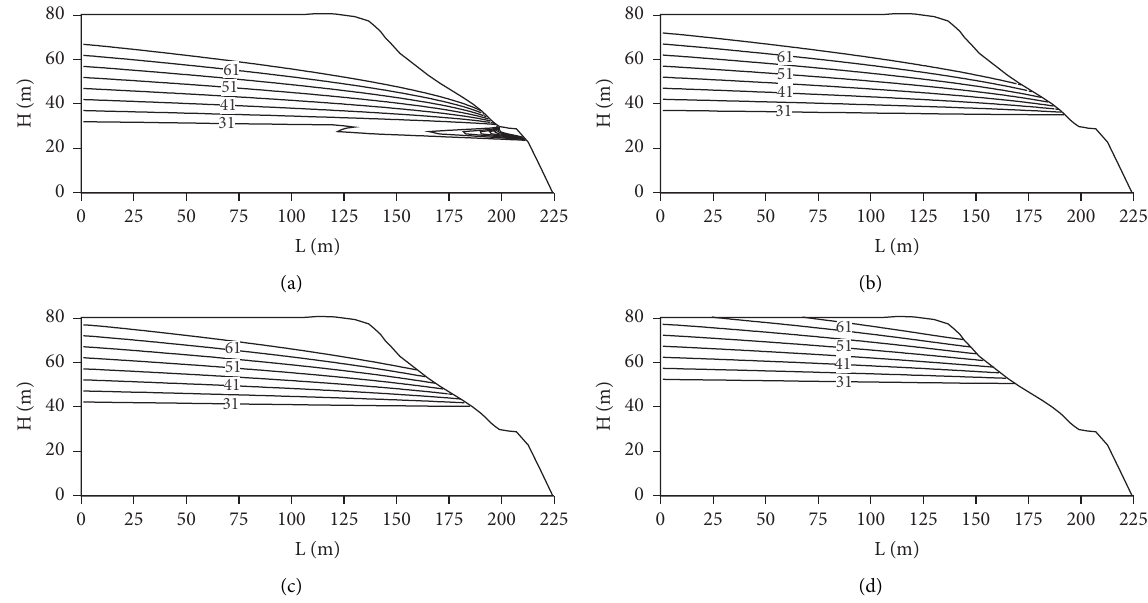
Figure 12: The relationship between groundwater and matric suction. (a) 0 kPa. (b) 50 kPa. (c) 100 kPa. (d) 200 kPa.